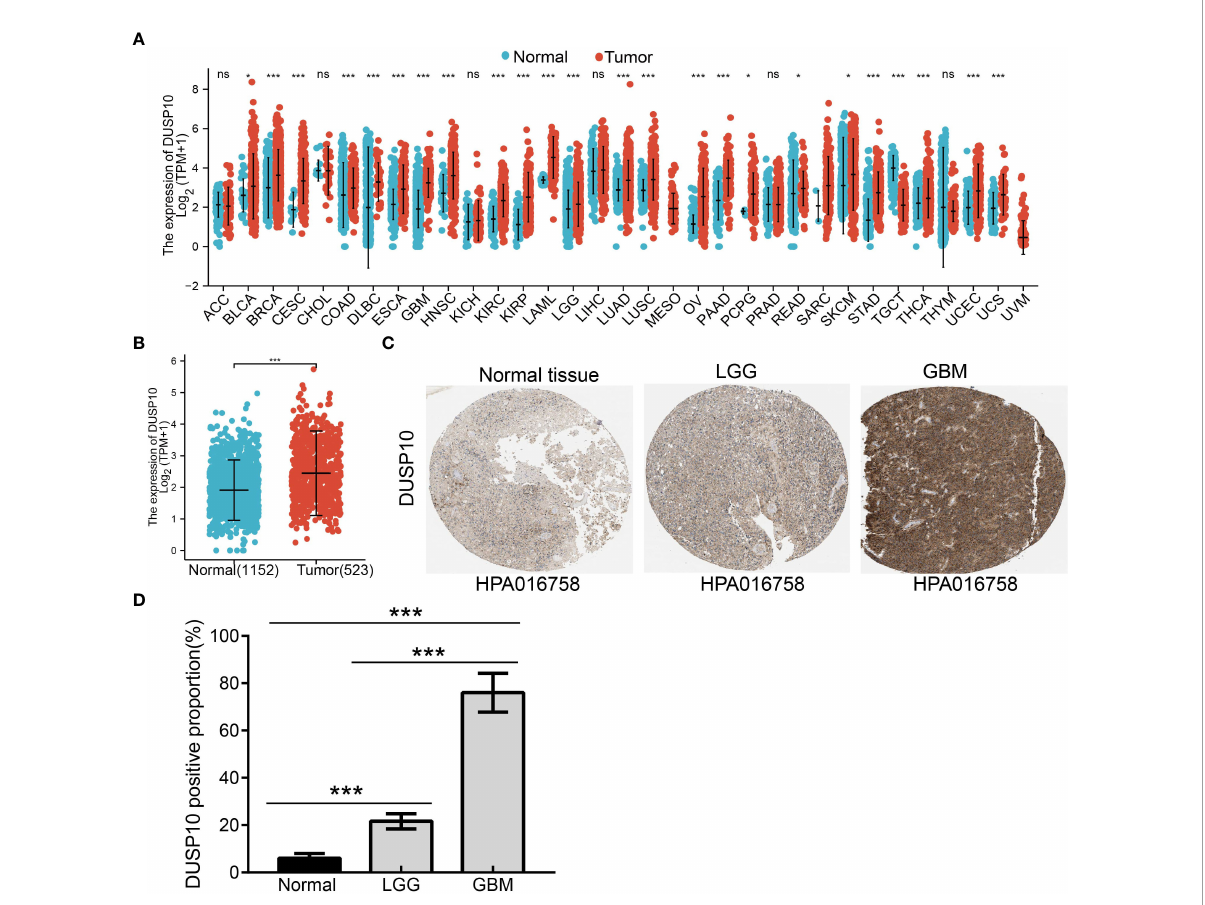
FIGURE 1 The expression level of DUSP10 in different tumors. (A) The expression level of DUSP10 gene in different cancers or speci fi c cancer subtypes was analyzed through TCGA/GTEx database. (B) DUSP10 expression in glioma and paired normal tissue in TCGA/GTEx database. (C, D) Differential expression of DUSP10 in glioma and normal tissues in the Human Protein Atlas database. NS: p >0.05. * p < 0.05, ** p < 0.01, *** p < 0.001. TCGA, The Cancer Genome Atlas; GTEx, Genotype-Tissue Expression